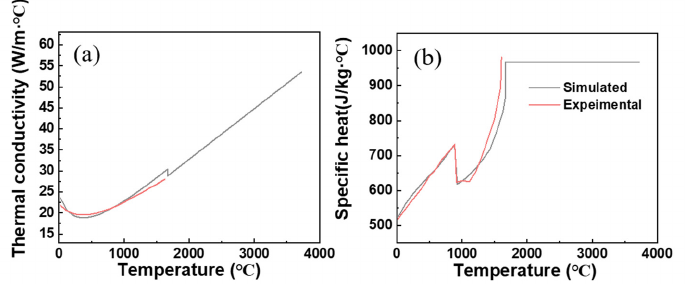
Figure 3. Thermophysical parameters of CP-Ti: ( a ) thermal conductivity; ( b ) specific heat.